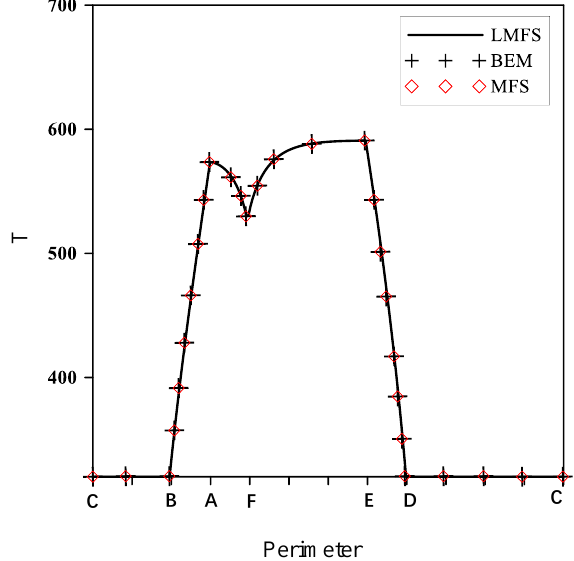
Figure 5. The boundary temperature when a = 0.25.